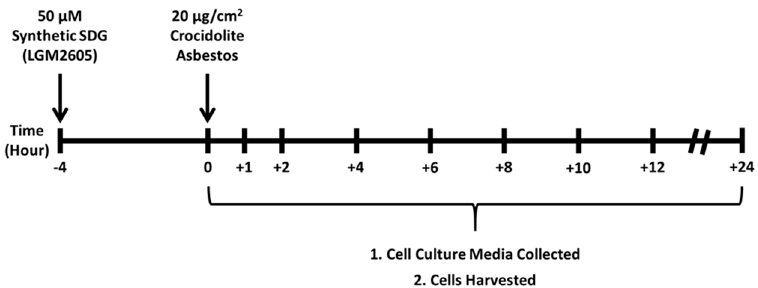
Figure 2. Experimental plan of asbestos exposure, LGM2605 Treatment, and Harvest Time Points. Murine peritoneal macrophages were exposed to 50 µ M synthetic SDG (LGM2605) 4-h prior to exposure to sterile UICC crocidolite (SPI Supplies) asbestos fibers (20 µ g/cm 2 ). Culture medium and cells were harvested at 0, 1, 2, 4, 6, 8, 12, and 24-h post asbestos exposure. Culture medium was evaluated for H 2 O 2 content, lactate dehydrogenase (LDH) release, levels of MDA and 8-iso Prostaglandin F2a, while cells were harvested for gene and protein expression analysis.